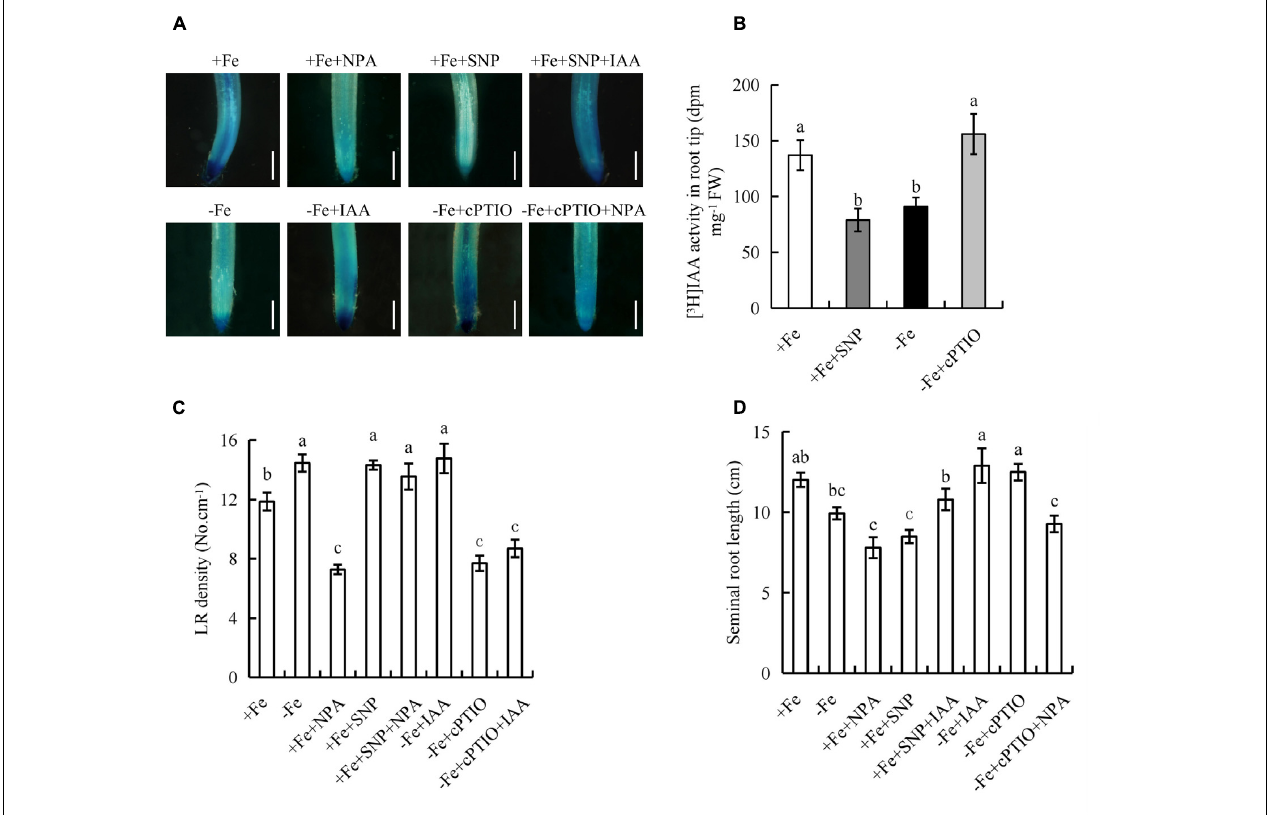
FIGURE 8 | Histochemical localization of DR5::GUS activity, [ 3 H]IAA transport and root morphology of seminal root in rice seedlings. Rice seedlings were grown in hydroponic media containing − Fe (0 µ M) and +Fe (20 µ M) in addition to IAA (100 nM), NPA (100 nM), SNP (30 µ M), and cPTIO (80 µ M) for 14 days. (A) Plants were stained for GUS activity in RT for 2 h at 37 ◦ C. Bar = 1 mm. (B) [ 3 H] IAA transport. (C) LR density. (D) Seminal root length. Data are means ± SE and bars with different letters indicate significant difference at P < 0.05 tested with